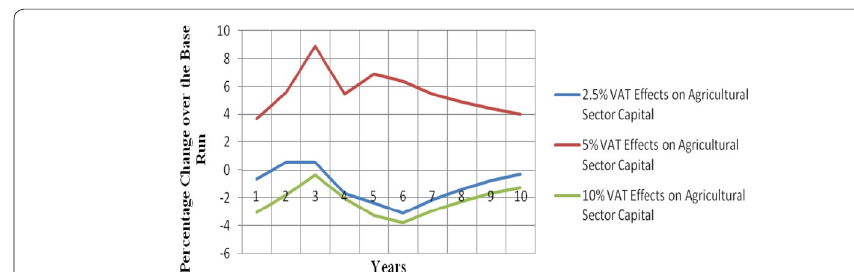
Fig. 29 Changes in capital stock in agriculture